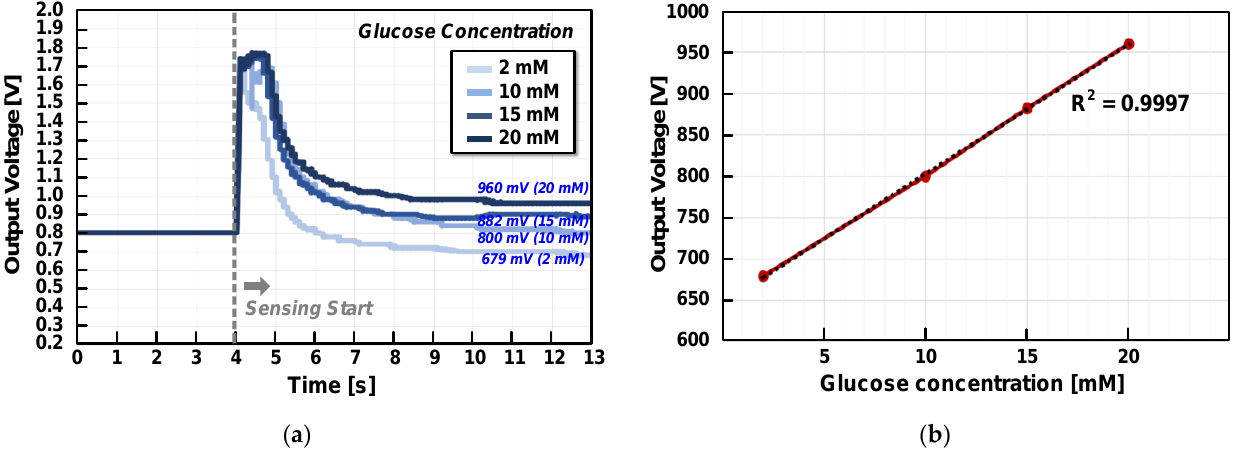
Figure 10. Die photograph.